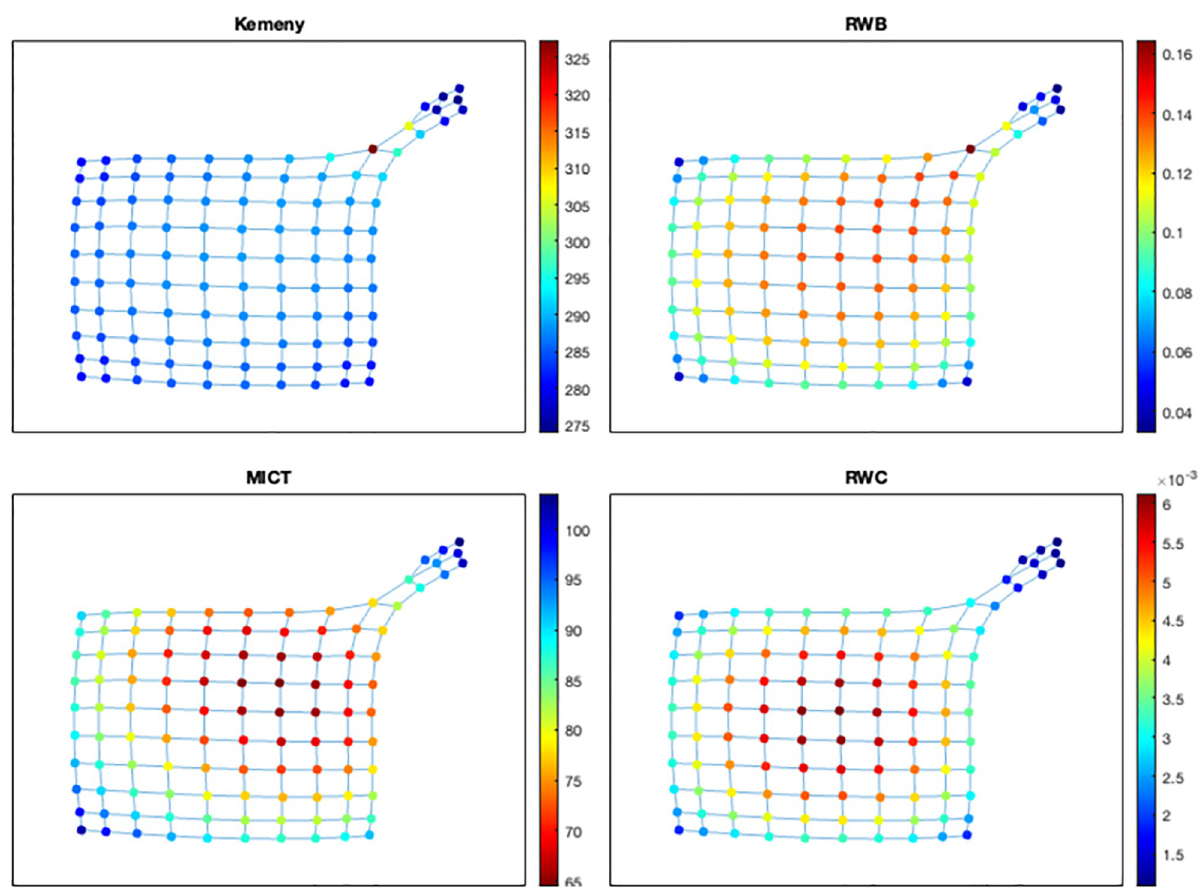
Fig 8. Ranking nodes in G (10, 3) based on the random walk-based